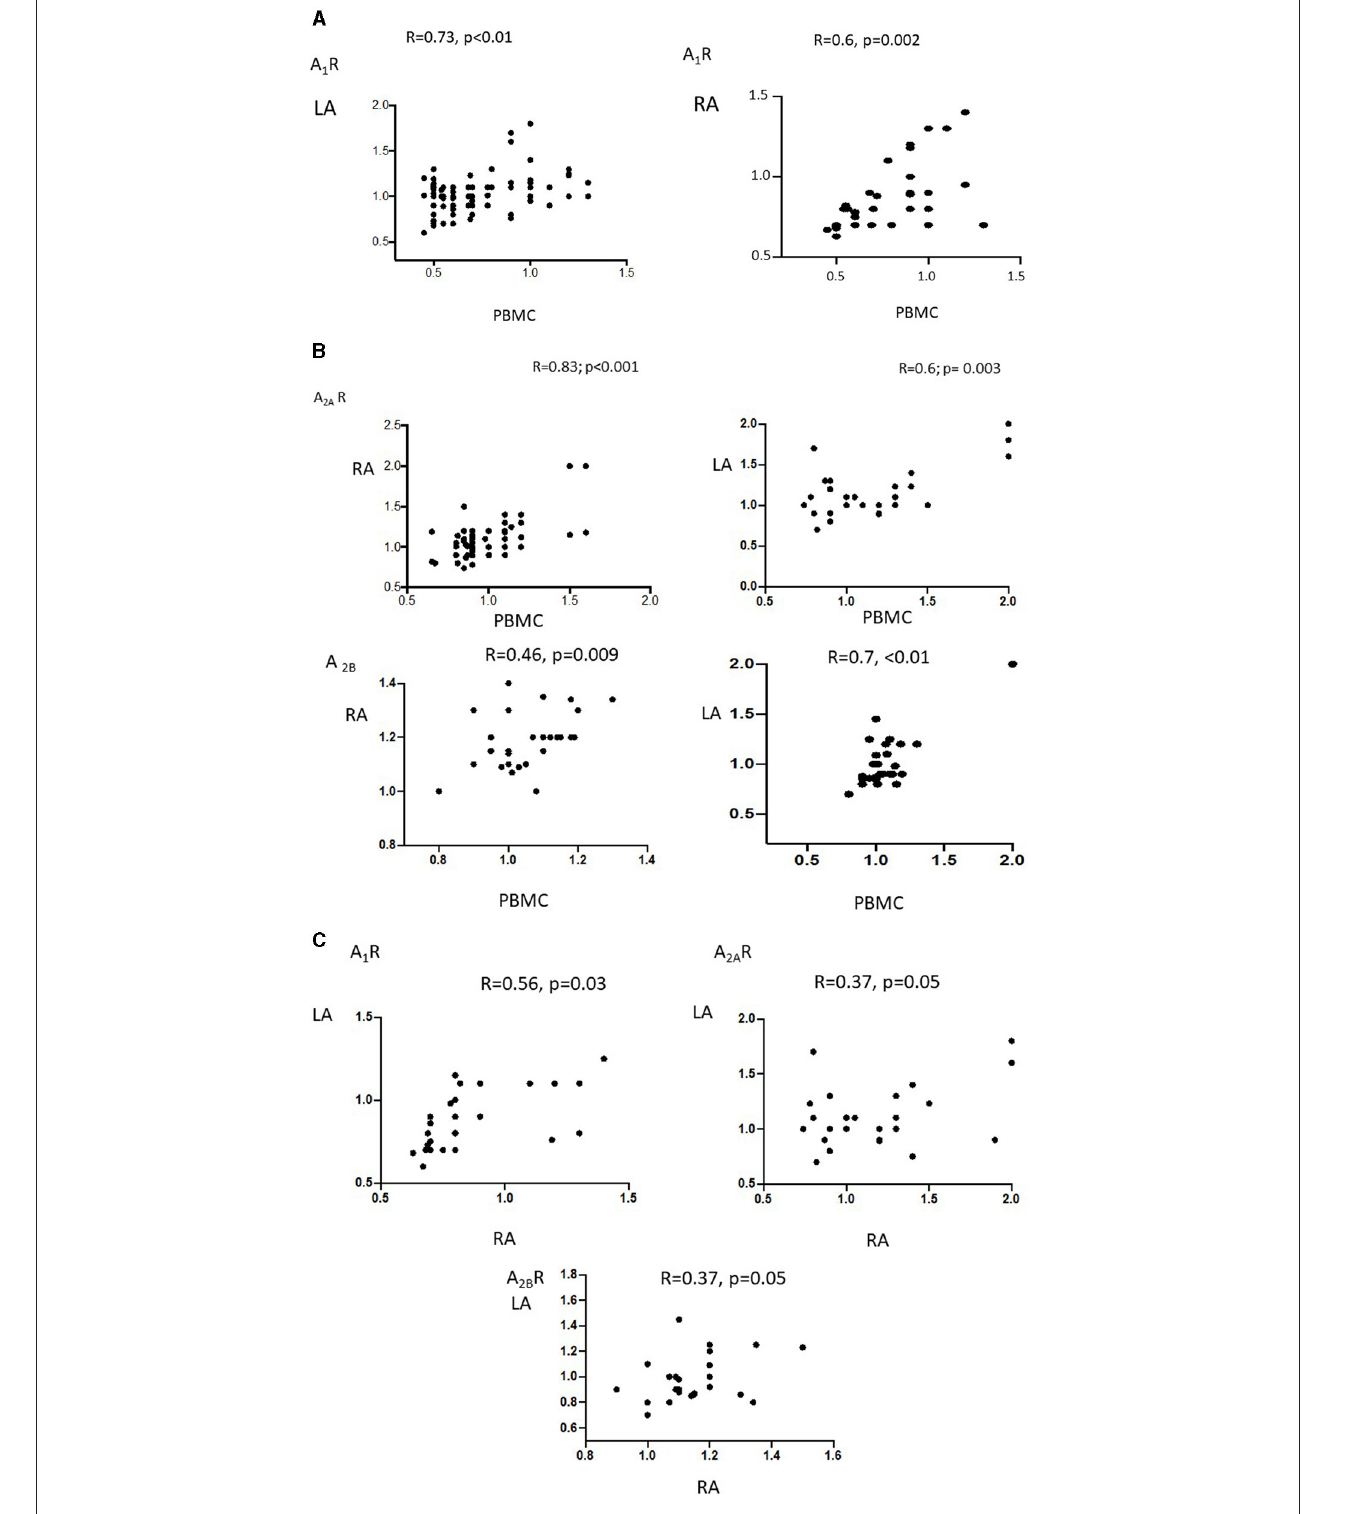
FIGURE 4 | Pearson’s R correlation between adenosine receptor expression by PBMCs in the LA (left panel) and RA (right panel) in patients undergoing cardiac surgery: (A) A 1 R, (B) A 2A R and A 2B R. In (C) the correlation between adenosine receptors subtypes in RA vs. LA.